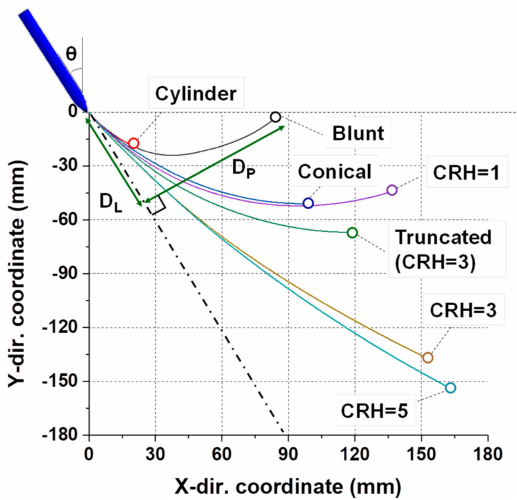
Figure 14. Trajectories of the projectiles and the final coordinates of the projectile tip with respect to the projectiles.